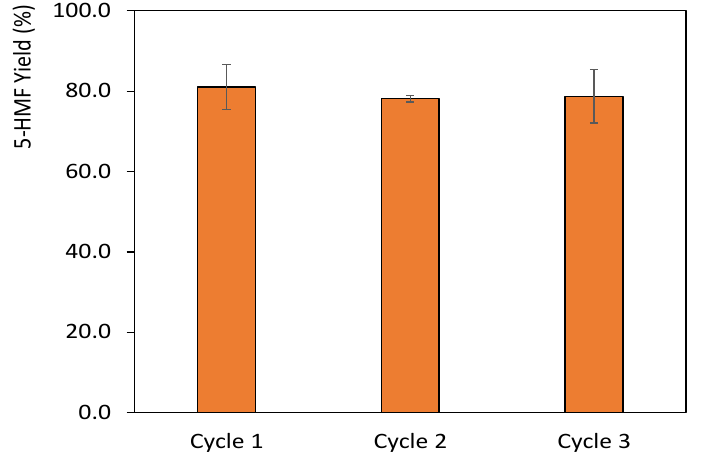
Figure 5. 5-HMF yields attained through 3 cycles involving the solvent reuse of the system composed of [Ch]Cl:Citric Acid (1:1) with 10 wt.% of GVL. The microwave-assisted reactions were carried out at 130 °C with 4 min of reaction and S/L ratio of 0.05.